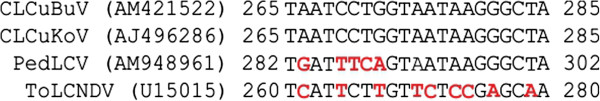
Alignment of the V2 gene sequences homologous to the amiRNA of the bogomoviruses used. Shown are the sequences of the V2 genes of Cotton leaf curl Burewala virus (CLCuBuV), Cotton leaf curl Kokhran virus (CLCuKoV) and Pedilanthus leaf curl virus (PedLCuV) as well as the AV2 gene of Tomato leaf curl New Delhi virus (ToLCNDV). Nucleotides differing from those of the CLCuBuV sequence are highlighted in red. Note that the sequences of amiRNAs P1C and P1D target (are complimentary to) the CLCuBuV sequence.